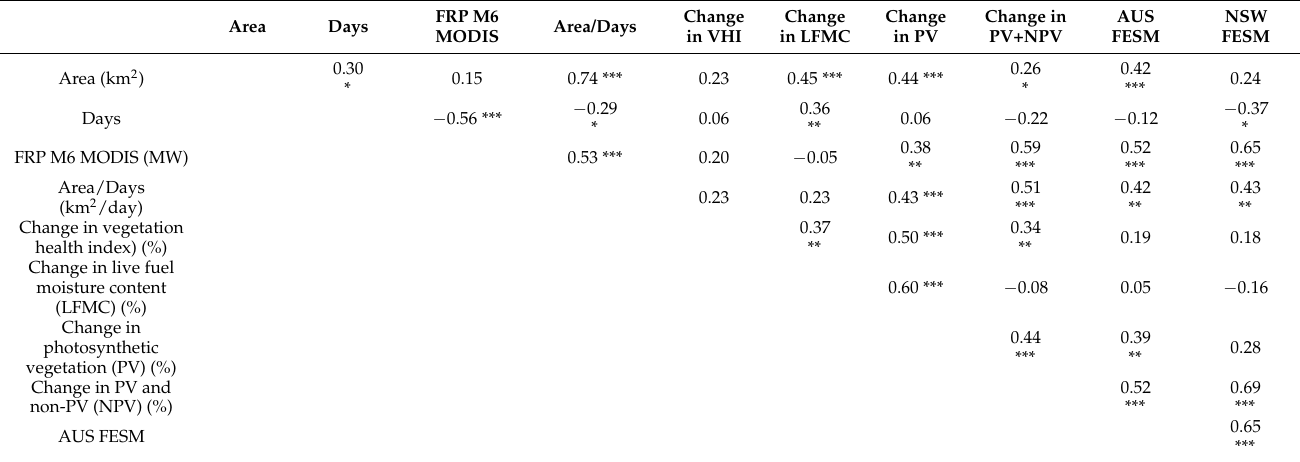
Table 4. Spearman correlation coefficient matrix between the response variables for the forest fires of the Black Summer in SE Australia ( n = 63). Data for the NSW FESM severity index was only available for the fires in New South Wales ( n = 45). The statistical significance of the correlations is given by asterisks (*** p < 0.001; ** p < 0.01; * p <